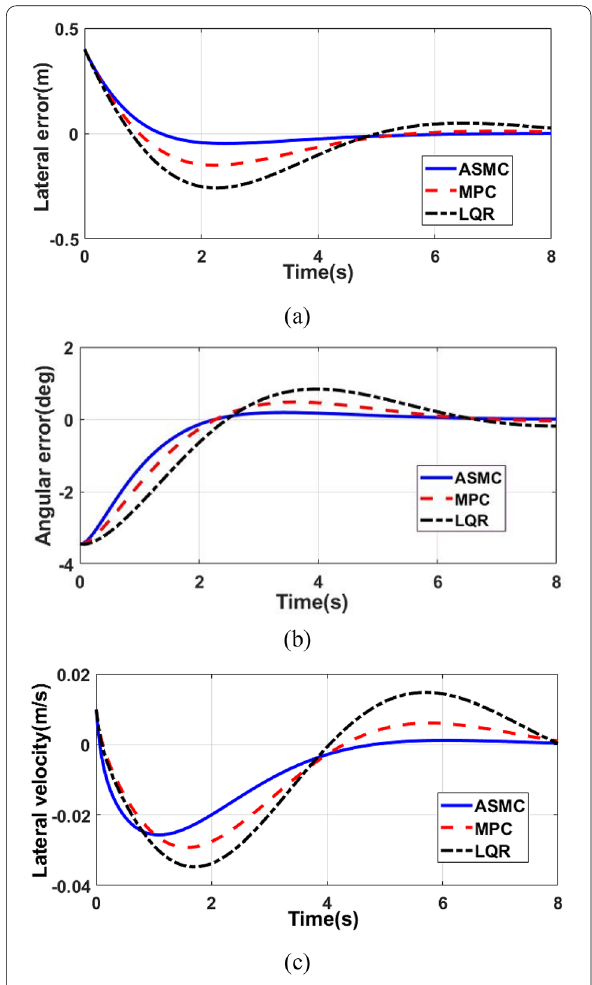
Figure 5 Vehicle states in simulation